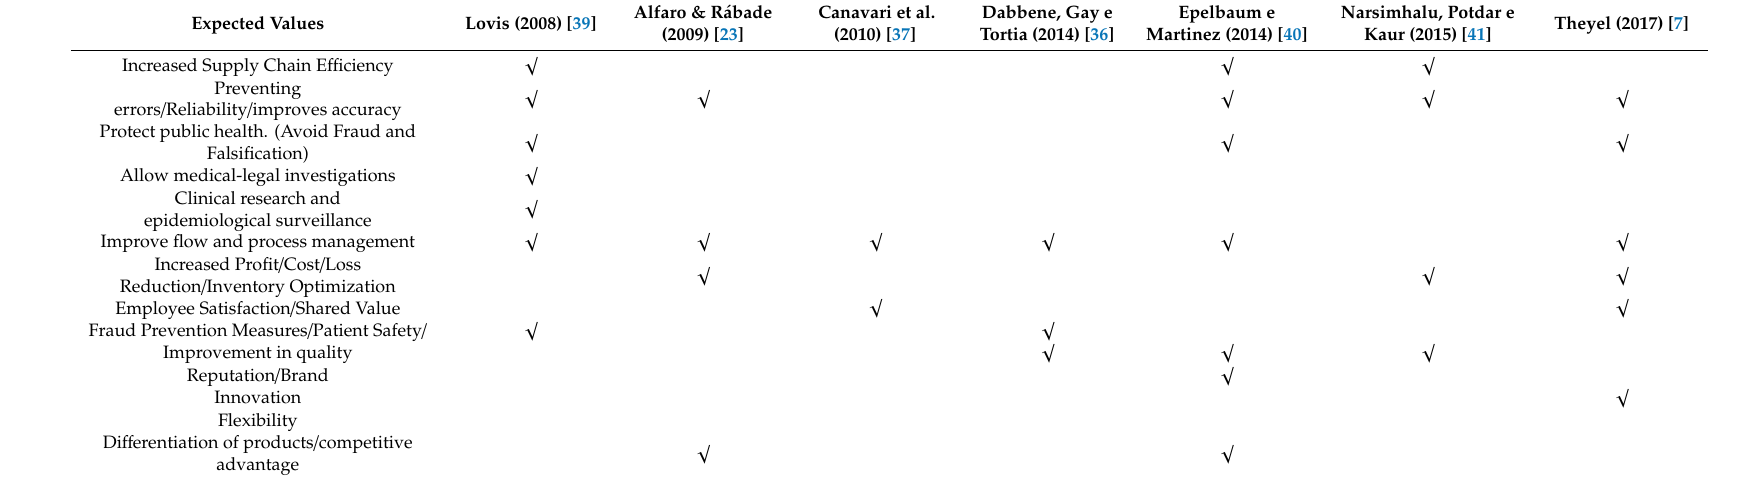
Table 3. Value creation of a drug traceability